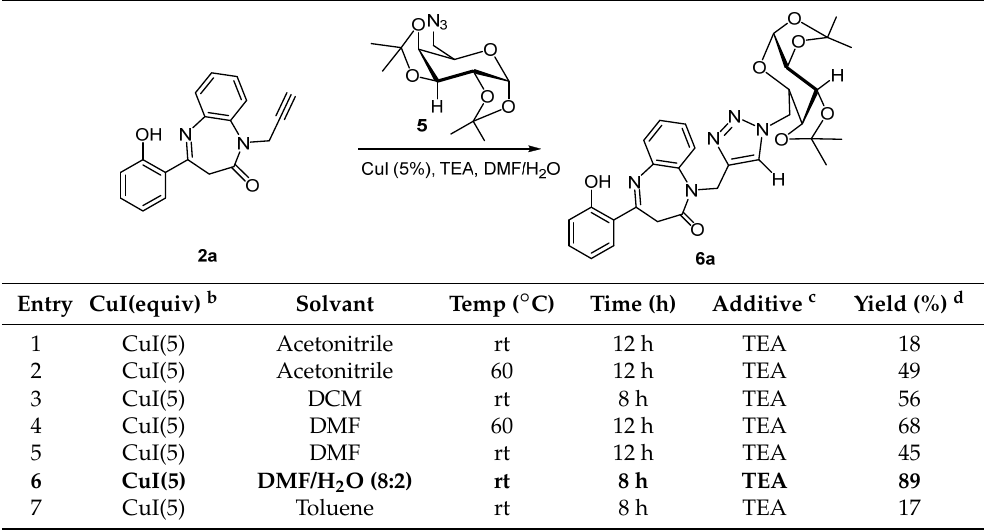
Table 4. Optimization of Cu(I)-catalyzed 1,3-dipolar cyclization for the synthesis of 1,2,3-triazoles 6a a .